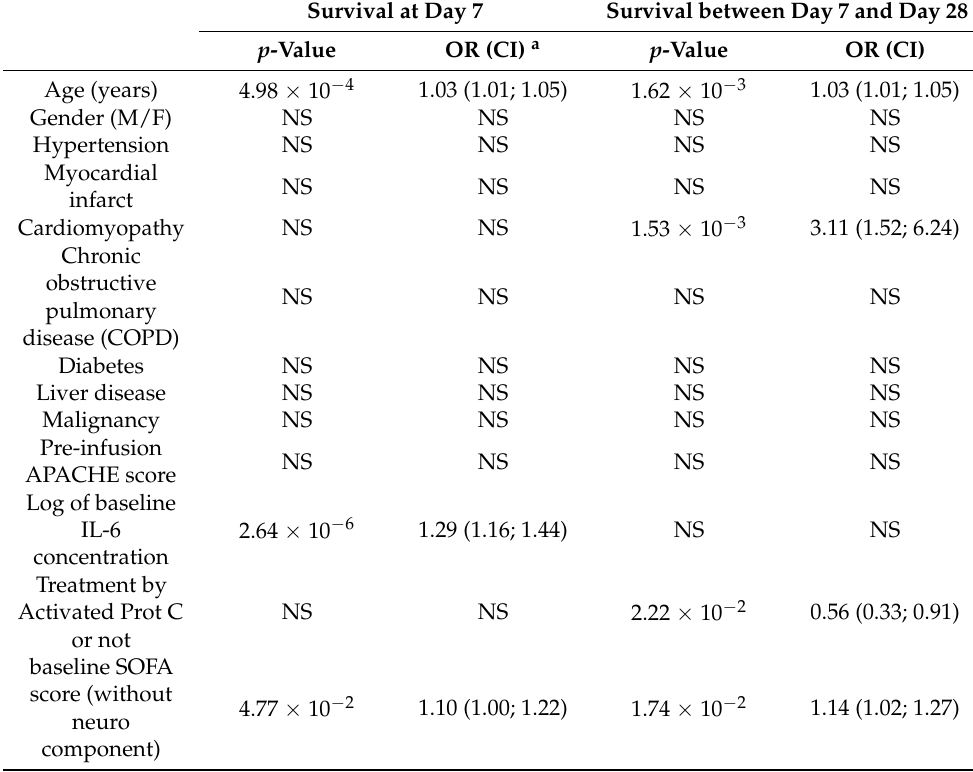
Table 5. Significant covariates for